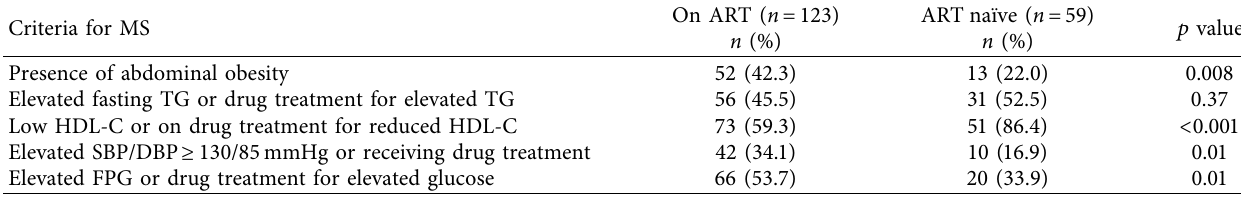
Table 2: Various criteria for metabolic syndrome by ART status ( n � 182).